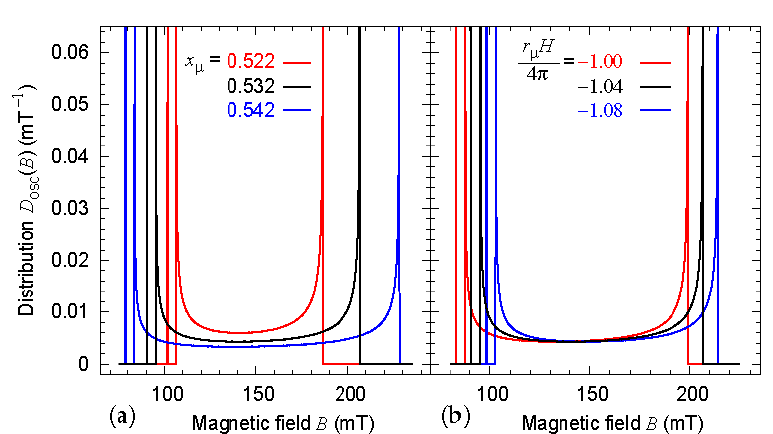
Figure 2. Simulations of the field distribution D osc ( B ) at the muon localization sites as a function of two muon-related parameters x µ and r µ H /4 π , respectively in ( a , b